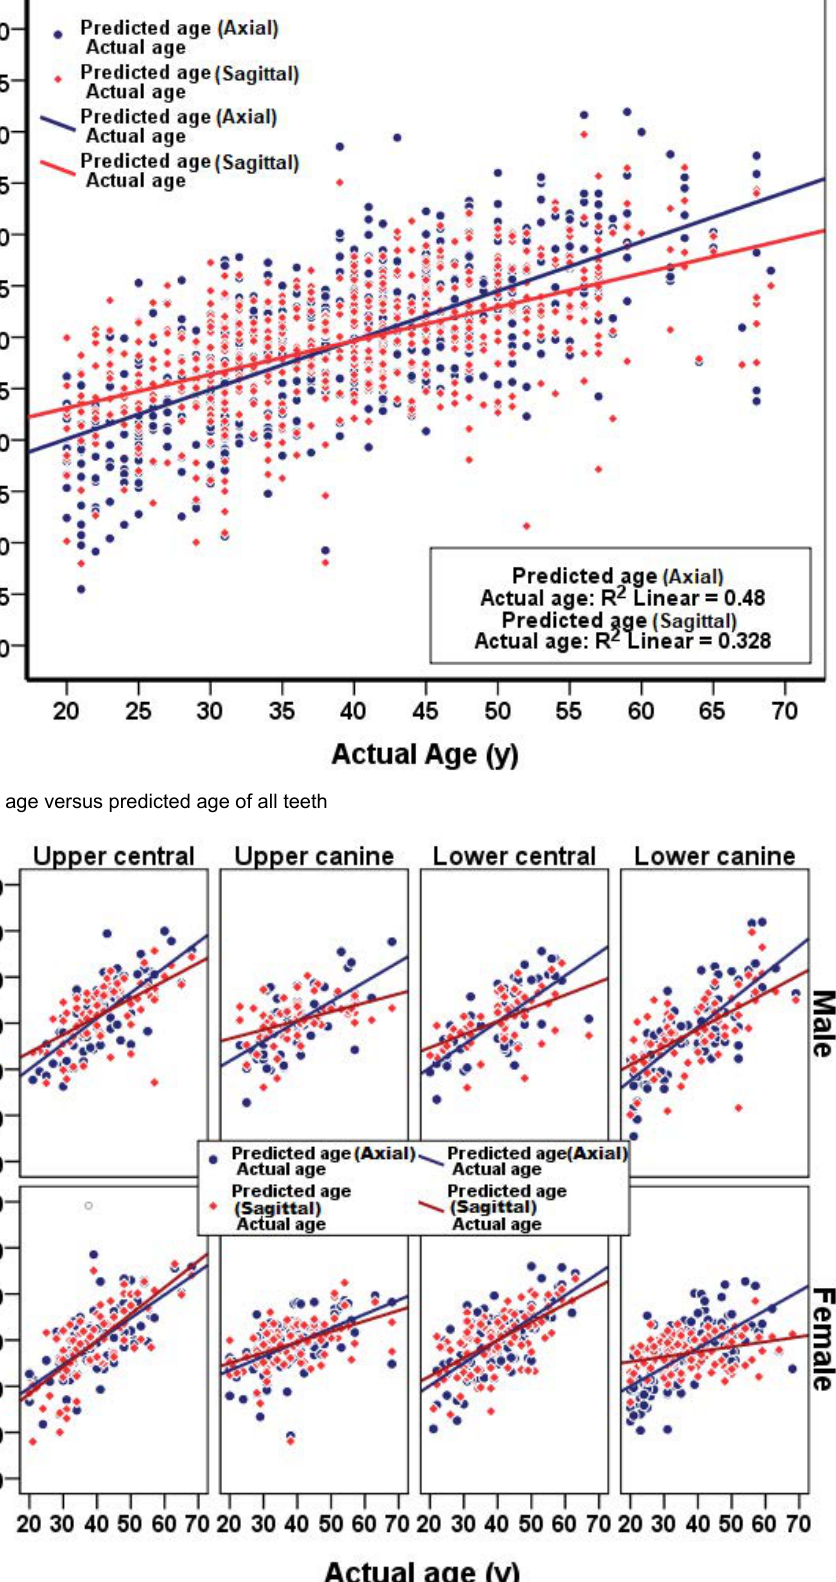
Figure 4- Plots of actual age versus predicted age of upper, lower central and canine